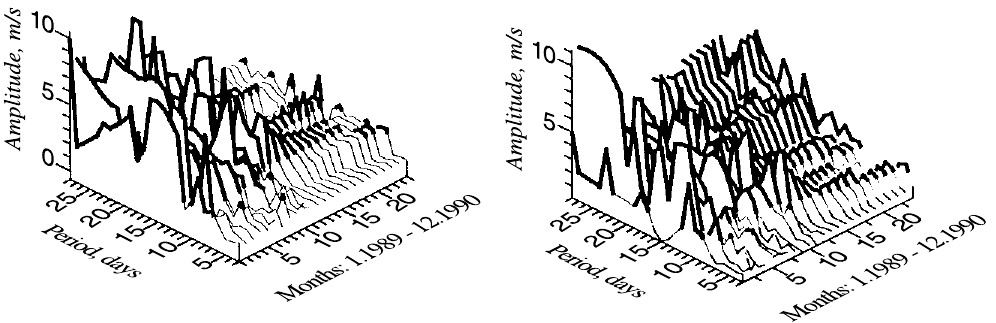
Fig. 9. Lower thermosphere zonal prevailing wind dynamic spectra at East Siberia and Central Europe.